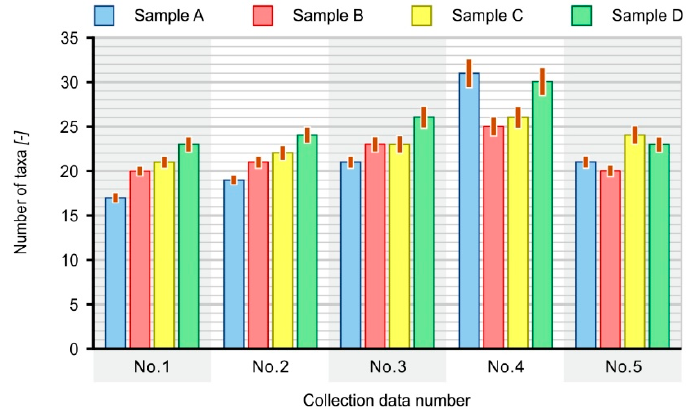
Figure 9. Number of microbial taxa detected on the paddles (A, B, C, D) during the study. Table 7. Cumulative sum of points obtained from samples during all